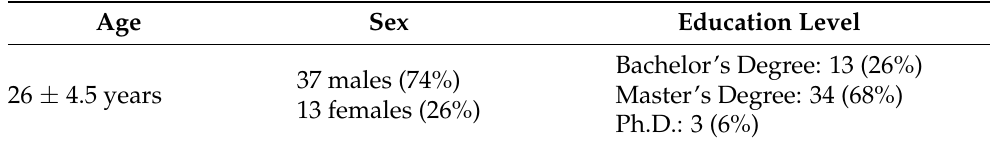
Table 1. Involved subjects and related demographic information.